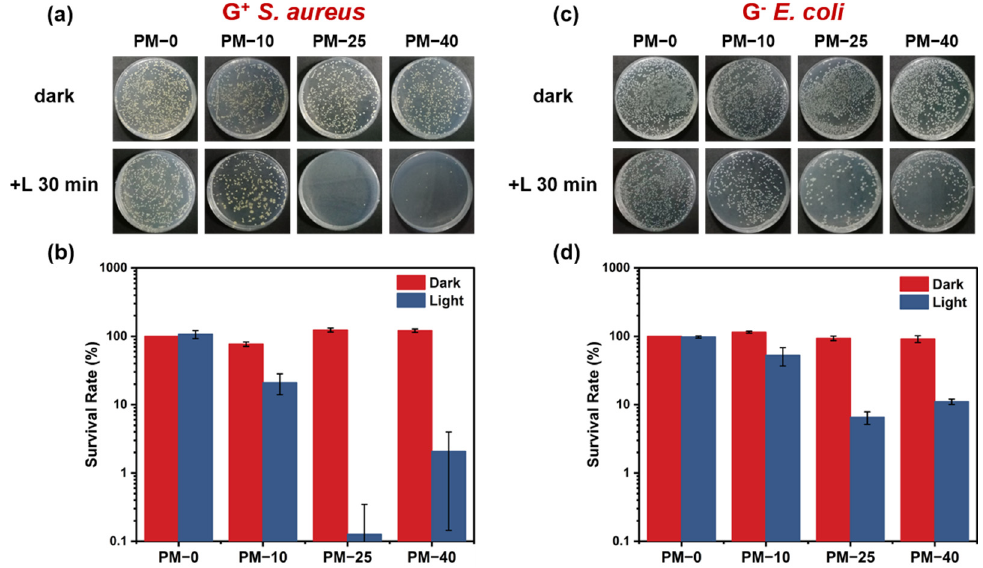
Figure 7. Photographs of residual S. aureus ( a ) and E. coli ( c ) bacterial colonies under various membranes treatments in the dark/light. S. aureus ( b ) and E. coli ( d ) relative bacterial survival rate. The error bars indicate the standard deviation ( n = 3).